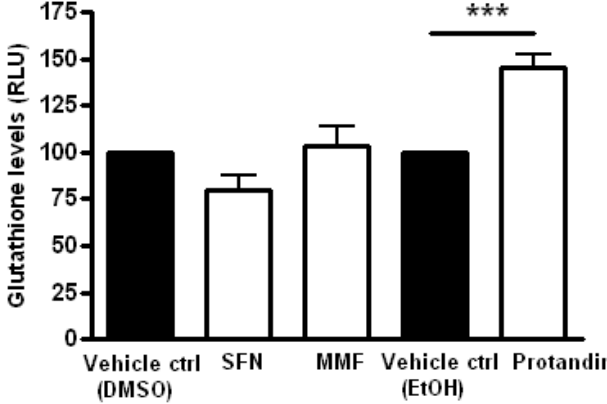
Figure 4. Protandim increases total glutathione levels in mature primary rat OLs. Mature primary rat OLs differentiated for 7 days were treated for 24 h with 5 μ M SFN, 90 μ M MMF,30 μ g/mL Protandim or their respective DMSO or EtOH control. Total glutathione levels were assayed using the GSH-Glo kit from Promega. Data are presented as percentage of control and expressed as the mean ± SEM of 3 independent experiments. Statistics reflect one-way ANOVA test with post hoc Bonferroni correction; *** p < 0.001.